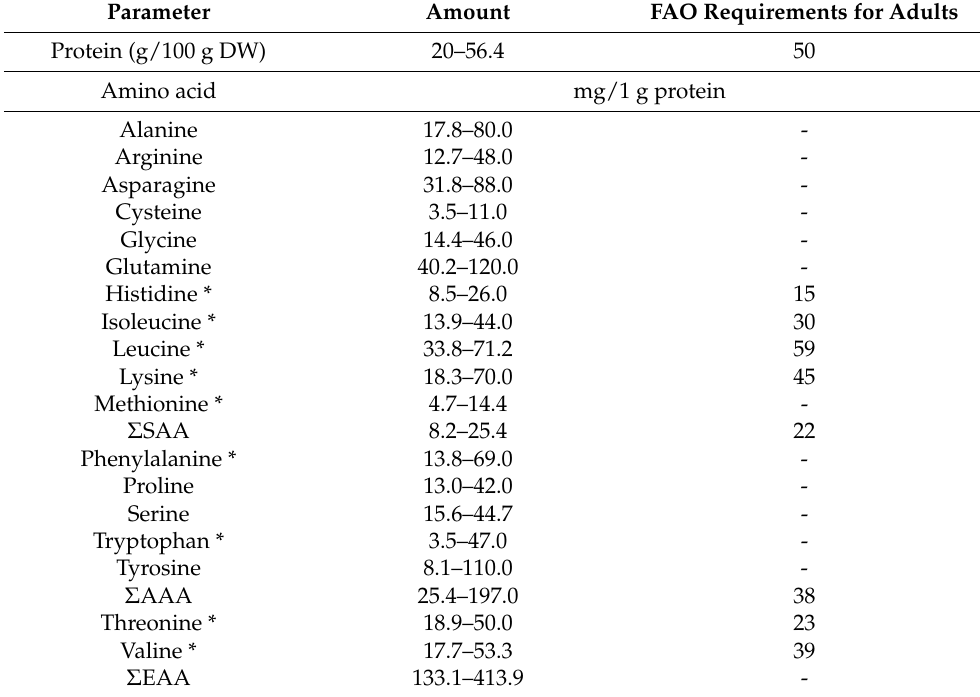
Table 3. Amino acids concentration in protein of Yarrowia lipolytica powder (dry